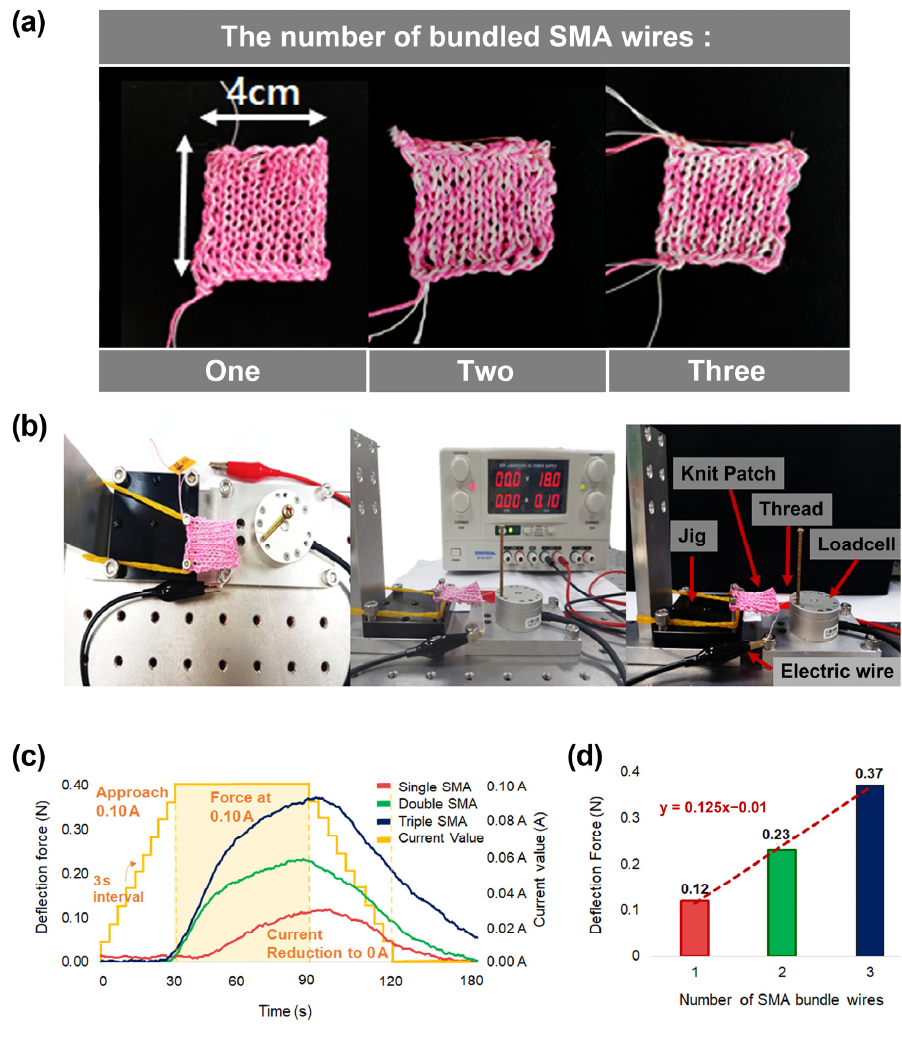
Figure 5. ( a ) Ten-course and ten-wale actuators with different numbers of SMA wires to create textile. ( b ) Test environment of force measurement. ( c ) Deformation force of textile actuator according to the number of SMA wires. ( d ) The rate of increase in force by increasing the number of SMA